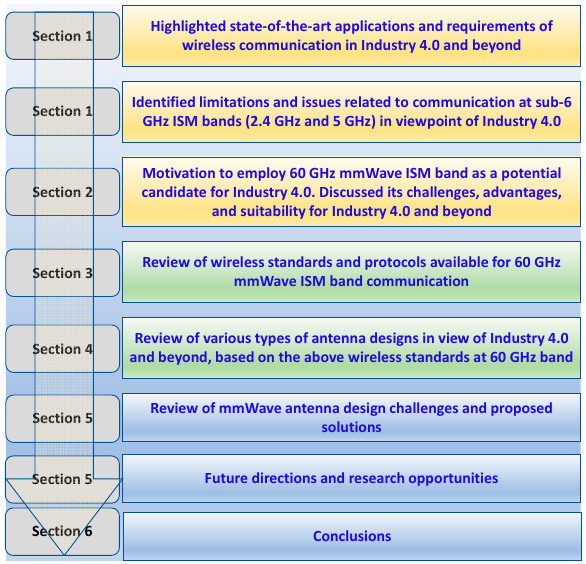
Figure 3. Organization of this review paper.